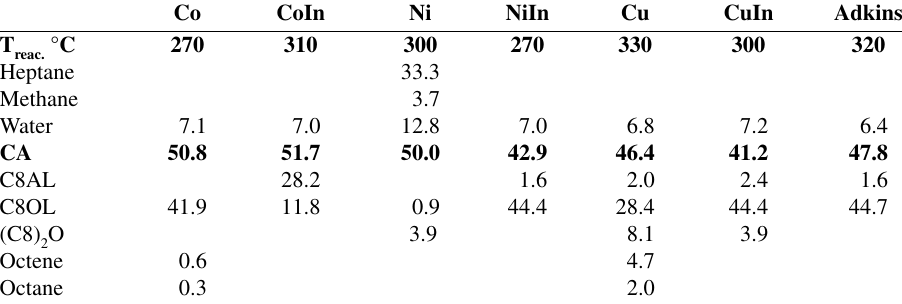
Co CoIn Ni NiIn Cu CuIn Adkins T reac.